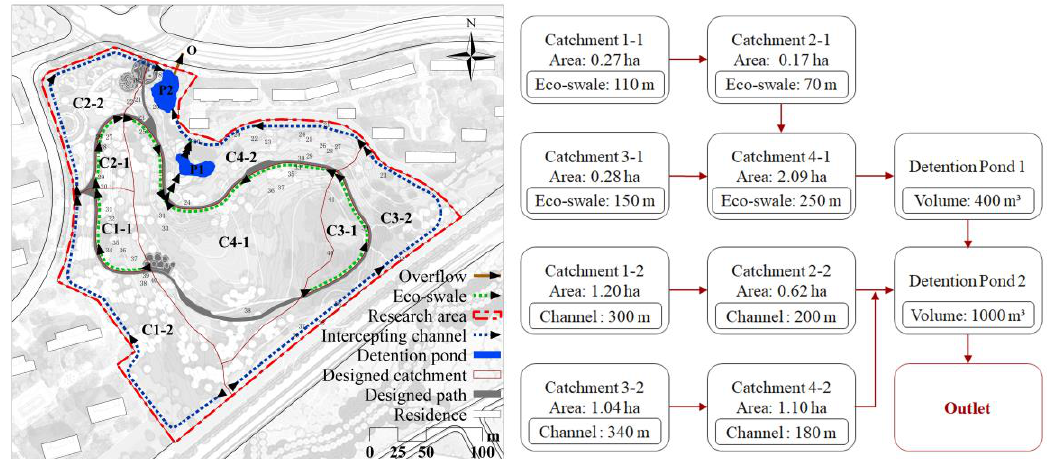
8 of 22 Figure 7. Facilities layout and design workflow diagram for S3. S4: Multi-level interception and storage strategy (The total storage volume increases in proportion to sub-catchment areas).